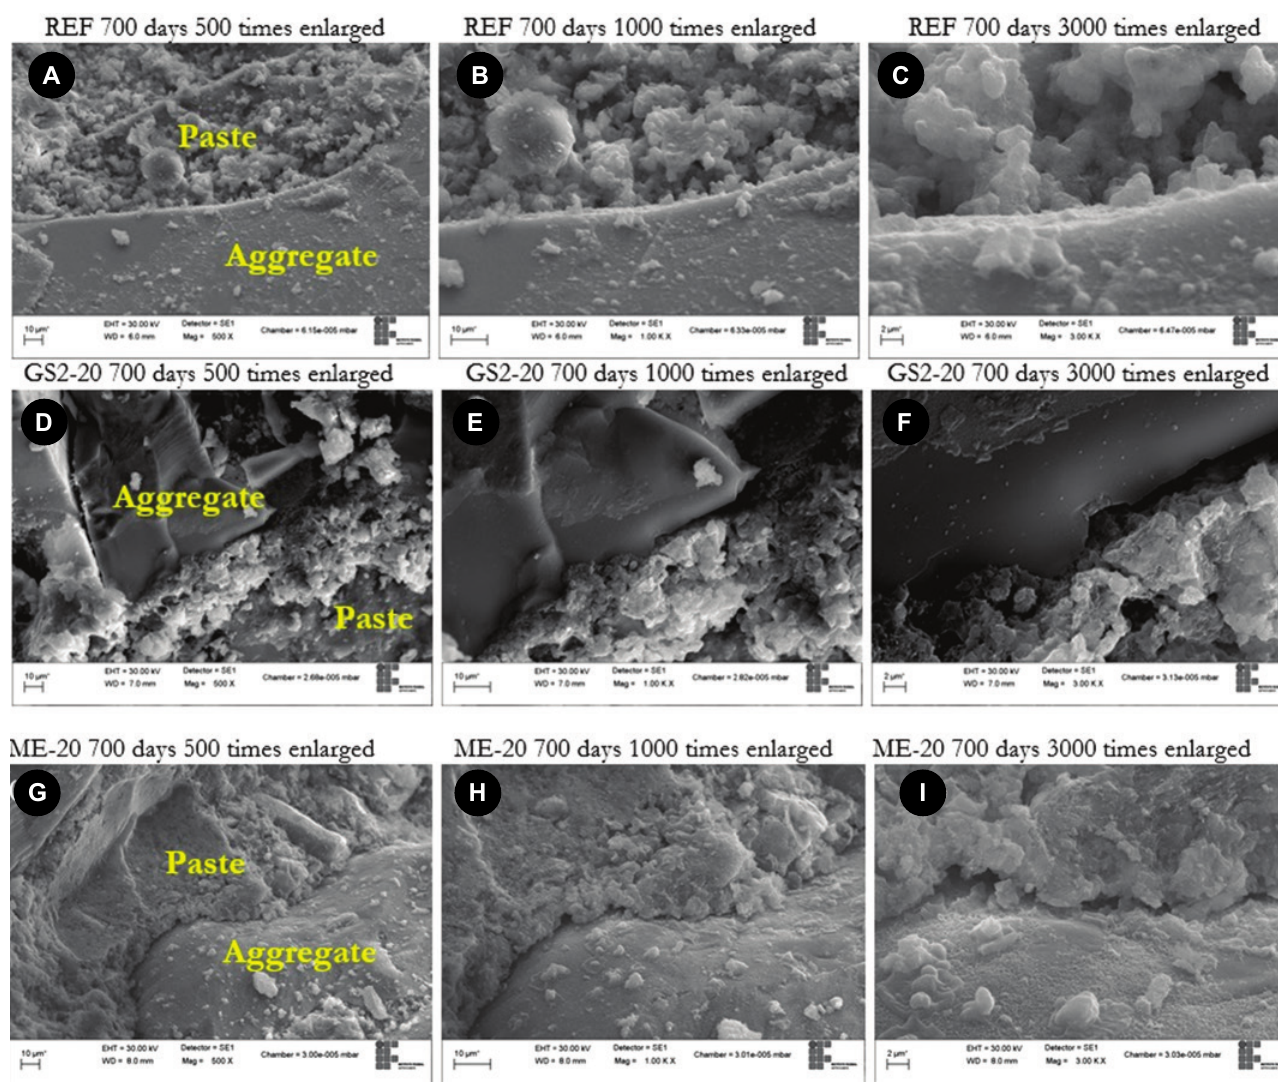
Figure 10 Microstructure analysis of concrete mixtures with GS2 and ME. (a) REF (500x magnification); (b) REF (1000x magnification); (c) REF (5000x magnification); (d) GS2-20 (500x magnification); (e) GS2-20 (1000x magnification); (f) GS2-20 (5000x magnification); (e) ME-20 (500x magnification); (f) ME-20 (1000x magnification); (g) ME-20 (5000x